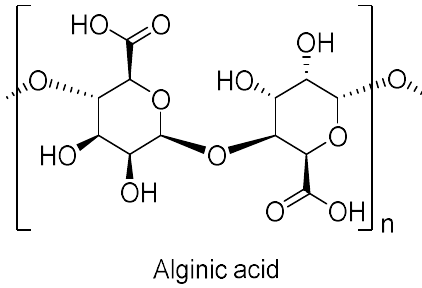
Figure 11. Chemical structure of alginic acid.